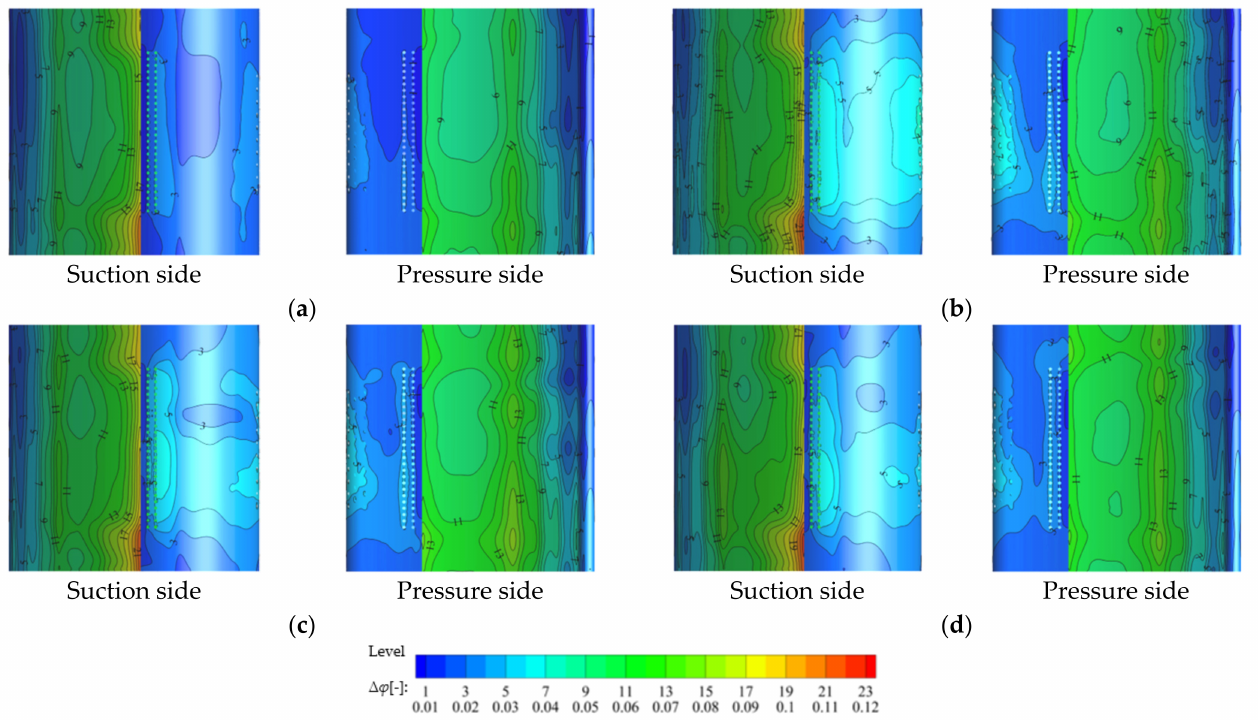
Figure 18. Cooling effectiveness increment distribution of coated vane for different cases. ( a ) Case 1: uniform inlet; ( b ) Case 2: HS only; ( c ) Case 3: HS and positive swirl; ( d ) Case 4: HS and negative